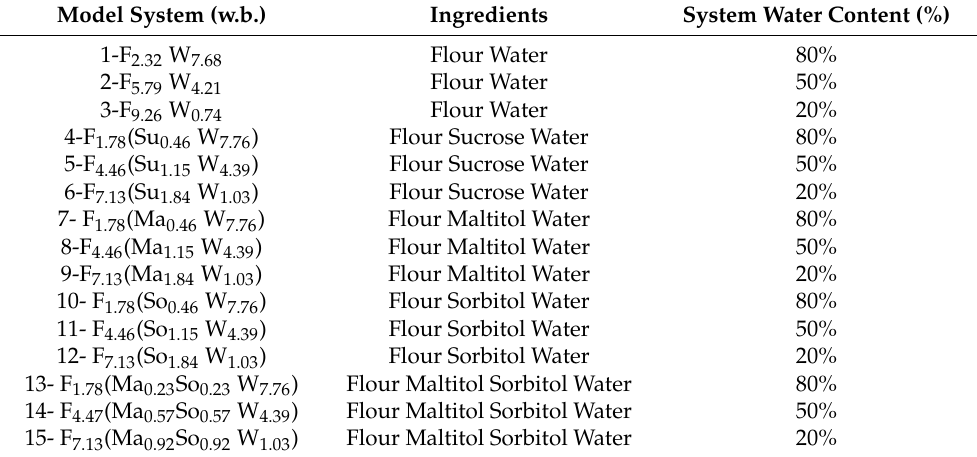
Table 3. Model system formulations with flour, water and sweeteners. Model System